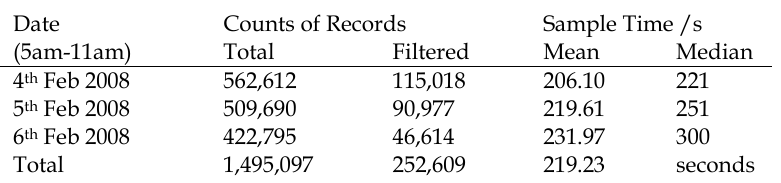
Table 2. GPS sampling